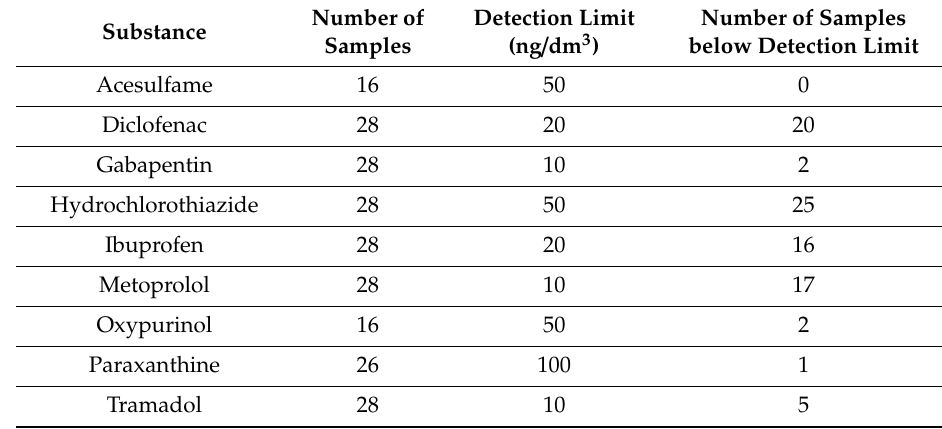
Table 8. Miletin Profile — basic statistical parameters